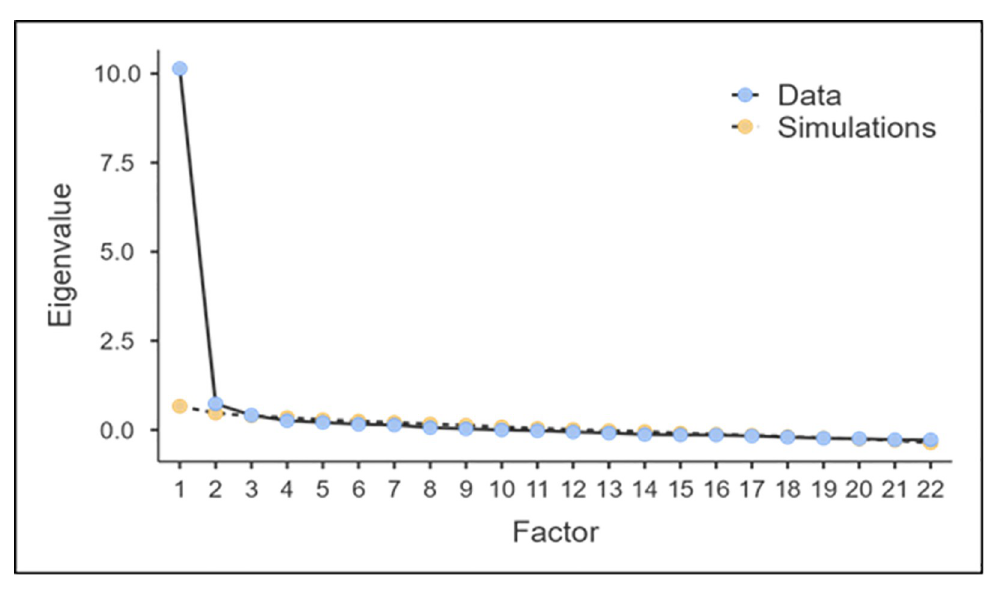
Fig 1. Scree plot for factor analysis of the